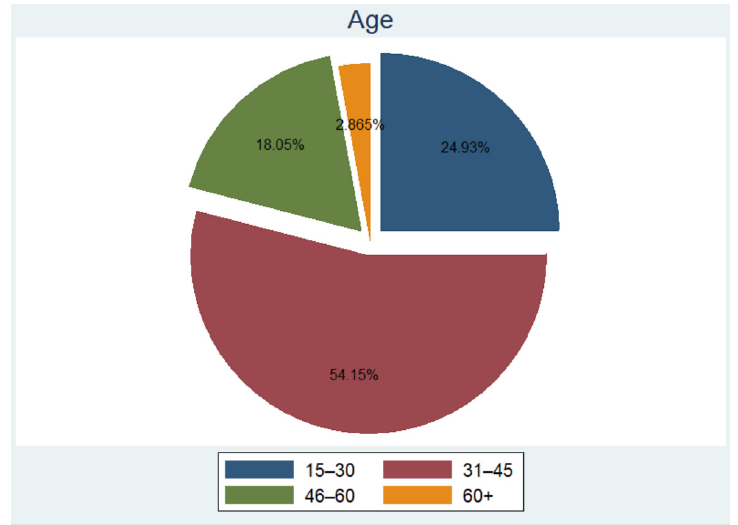
Figure 5. Age decomposition.